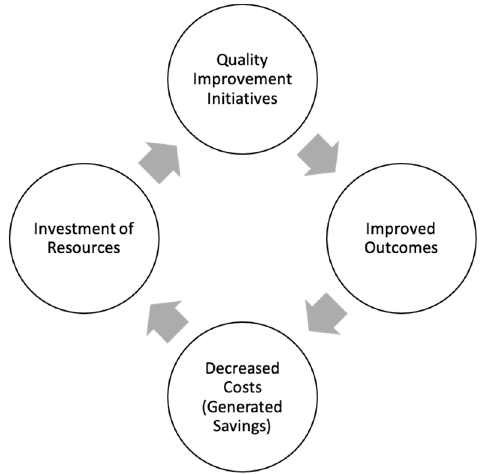
Figure 3. The relationship between quality improvement, outcomes, and costs.